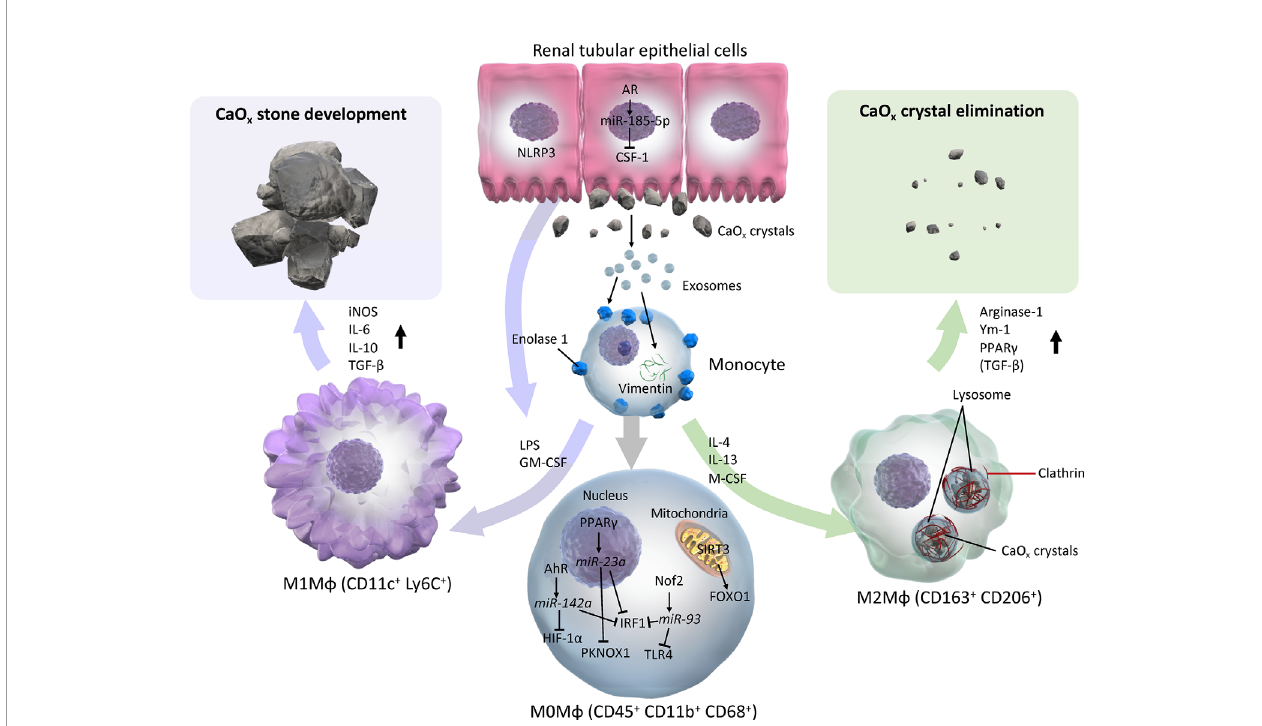
FIGURE 3 | Schema of evidence synthesized from current literature regarding roles of M1 and M2 macrophages in CaOx stone development. M1 or M2M j s are usually differentiated from monocytes and M0 (with neutral polarization) M j s via various cytokines/chemokines by direct and indirect in fl uences from CaOx